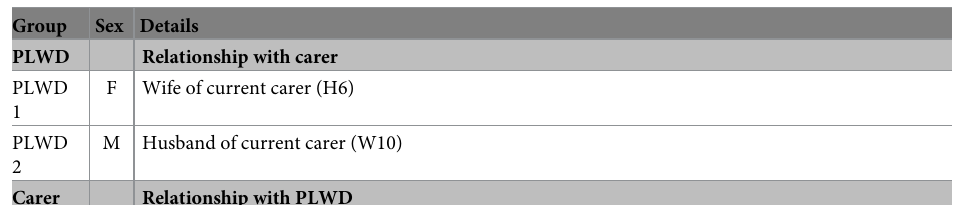
Table 1. Summary of